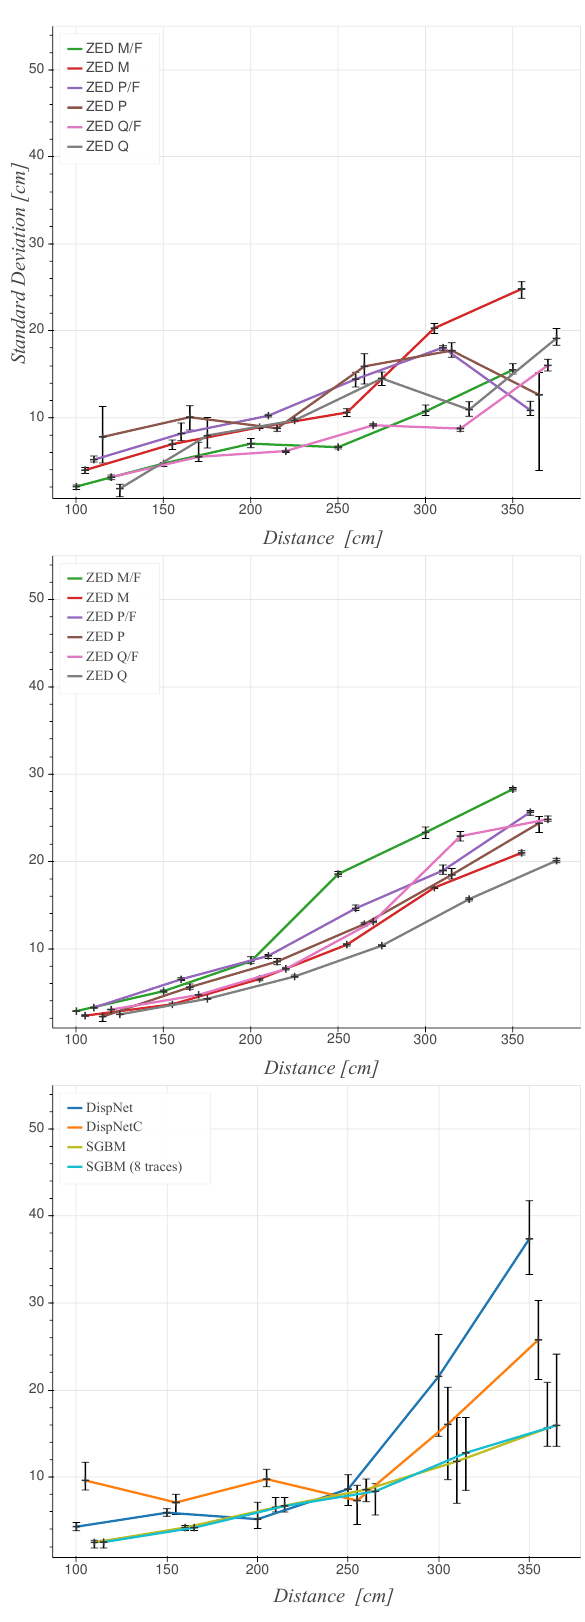
Figure 4. Deviation between the measured and the determined distance for 10 measurements. (a) Homogeneous area using stereolabs; (b) Textured area using stereolabs; (c) Textured area using DispNet and